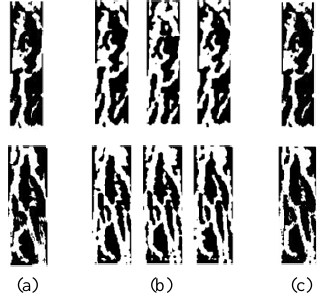
Figure 11. The results for template improvement based on average approach. ( a ) templates generated by average approach; ( b ) samples for template improvement; ( c ) improving template using the average approach. (The samples in the first row are from the HKPU Database and the samples in the second row are from the FV-USM